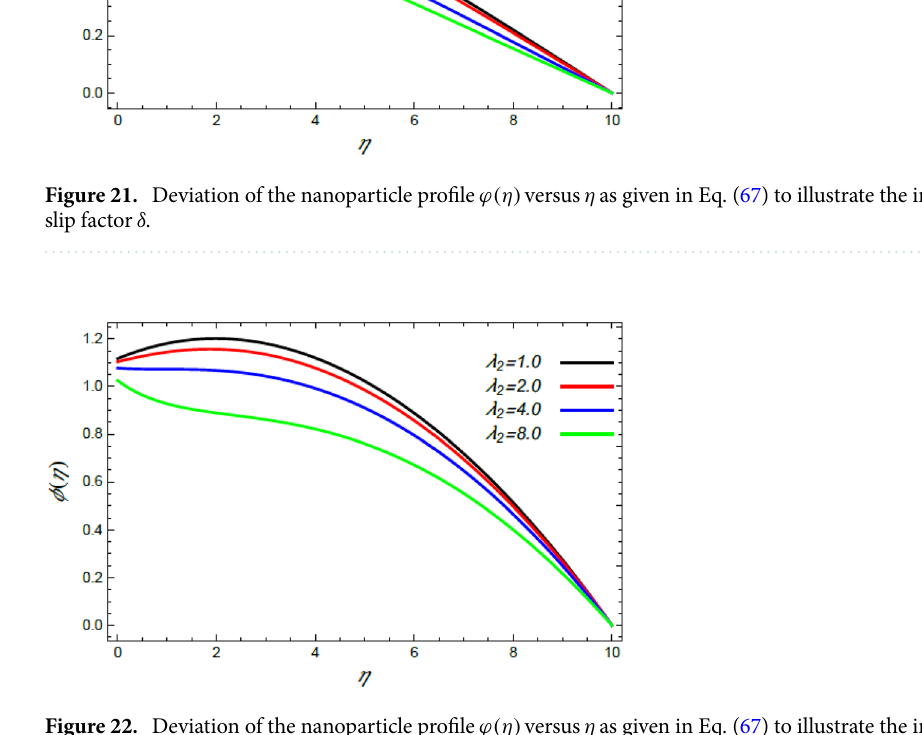
Figure 22. Deviation of the nanoparticle profile ϕ(η) versus η as given in Eq. (67) to illustrate the impact of the Deborah factor (cid:31) 2 .